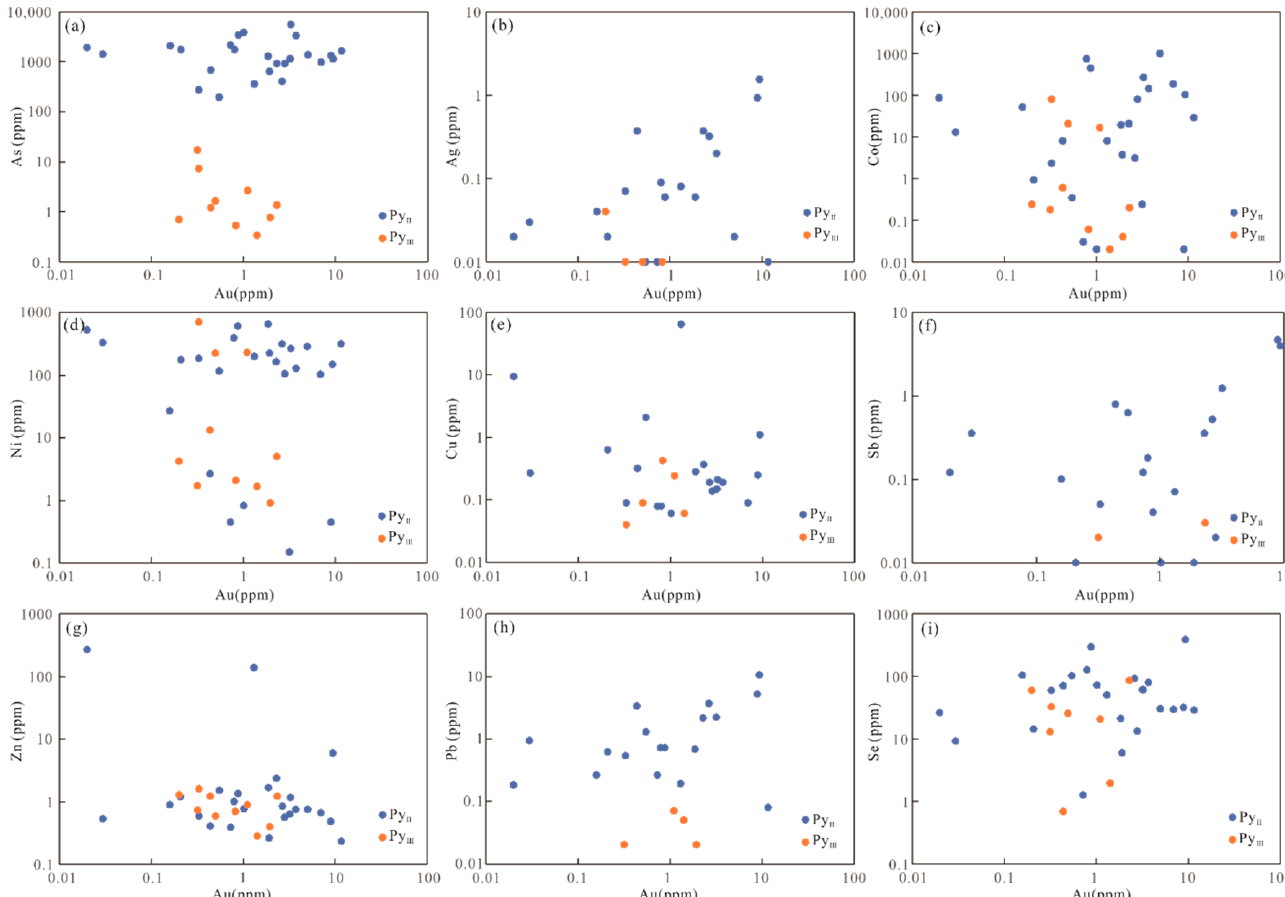
Figure 7. Binary plots of ( a ) As, ( b ) Ag, ( c ) Co, ( d ) Ni, ( e ) Cu, ( f ) Sb, ( g ) Zn, ( h ) Pb, and ( i ) Se vs. Au for pyrite formed in the syn-ore stage of the Shuangwang gold deposit.